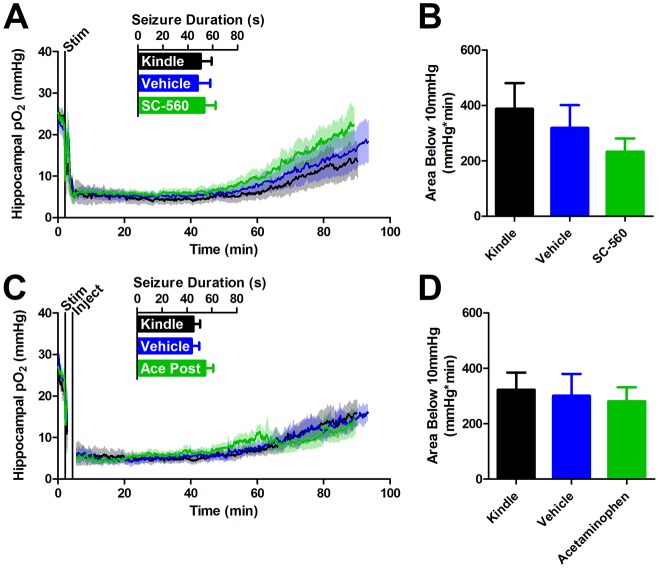
COX-1 or postictal COX-1/2 inhibition do not inhibit severe hypoxia.(A) SC-560 (20 mg/kg) pre-administration did not significantly alter seizure duration or the resulting oxygen profile (n = 5). (B) Quantification of (A). No differences in the severe hypoxia were observed with SC-560 pre-treatment. (C) Acetaminophen (250 mg/kg) was administered immediately after a seizure. No significant differences were observed in seizure duration or the resulting oxygen profiles (n = 5). (D) Quantification of (C). No significant differences were observed in the severe hypoxia with acetaminophen post-treatment.